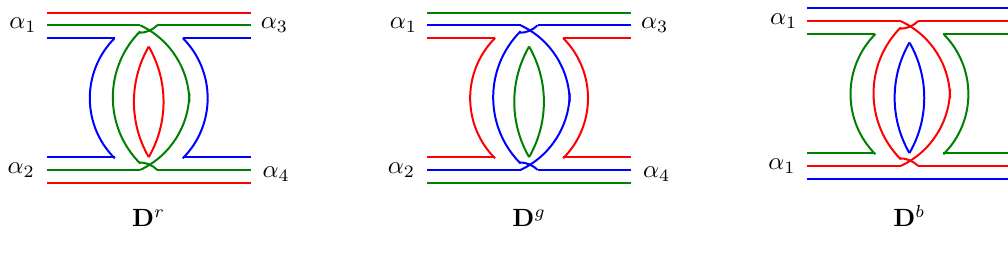
Figure 5. Dipoles D (cid:11) 1 (cid:11) 2 (cid:11) 3 (cid:11) 4